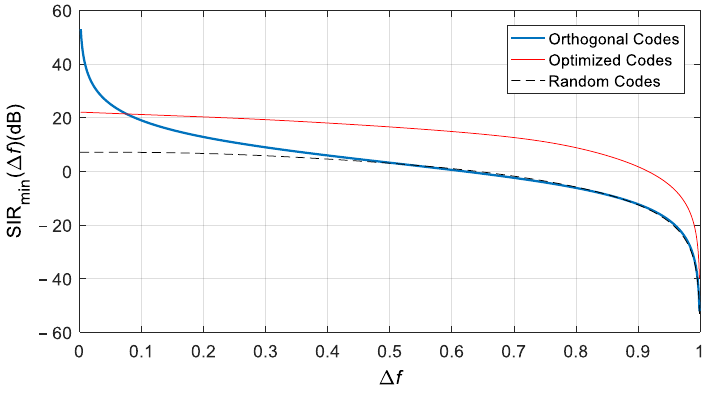
Figure 8. Comparison of 𝑆𝐼𝑅 𝑚𝑖𝑛 (Δ𝑓) .